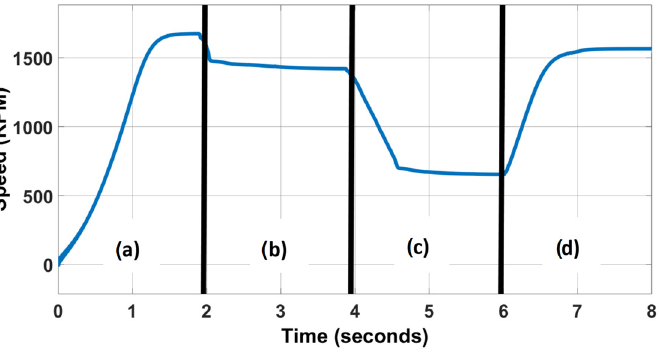
Figure 6. Speed variation ranges from: (a) 0% to 100%; (b) 100% to 80%; (c) 80% to 35%; (d) 35% to 90%.